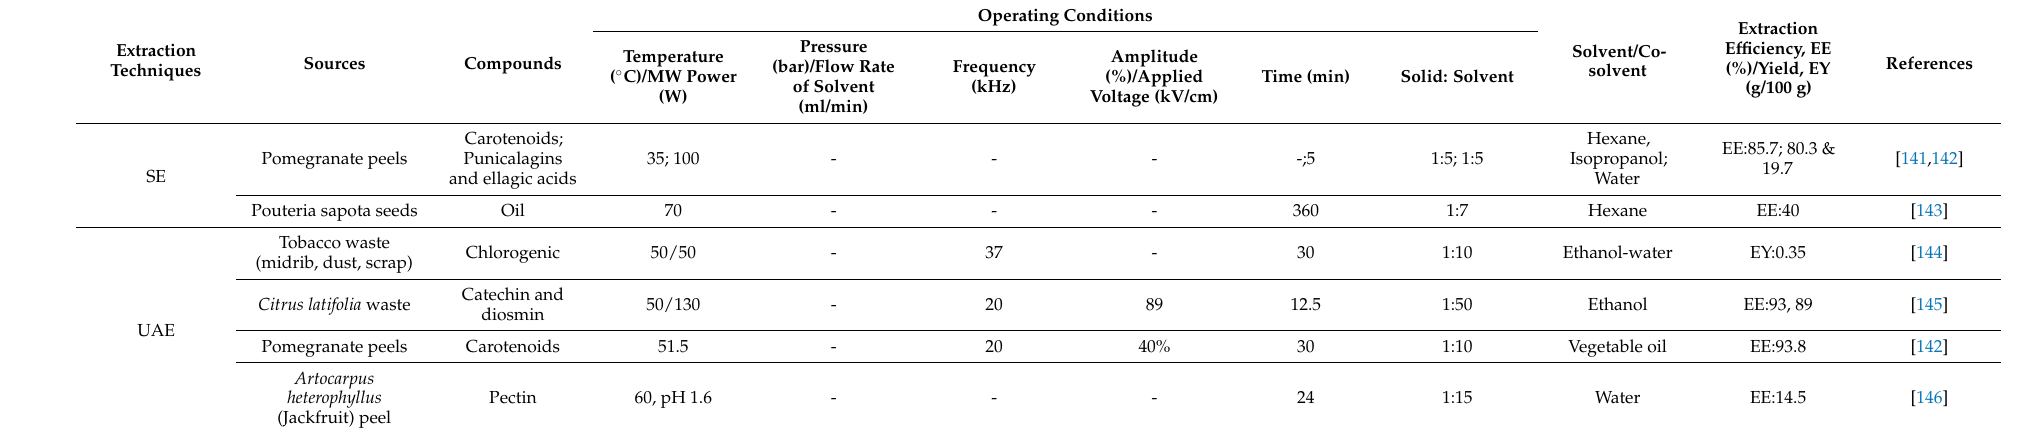
Table 2. Different techniques for extraction of bioactive compounds and their operating